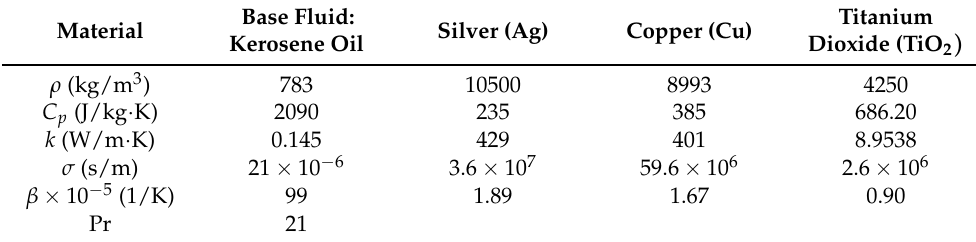
Table 2. Thermo-physical properties of nanoparticles and the base fluid from [35,36].